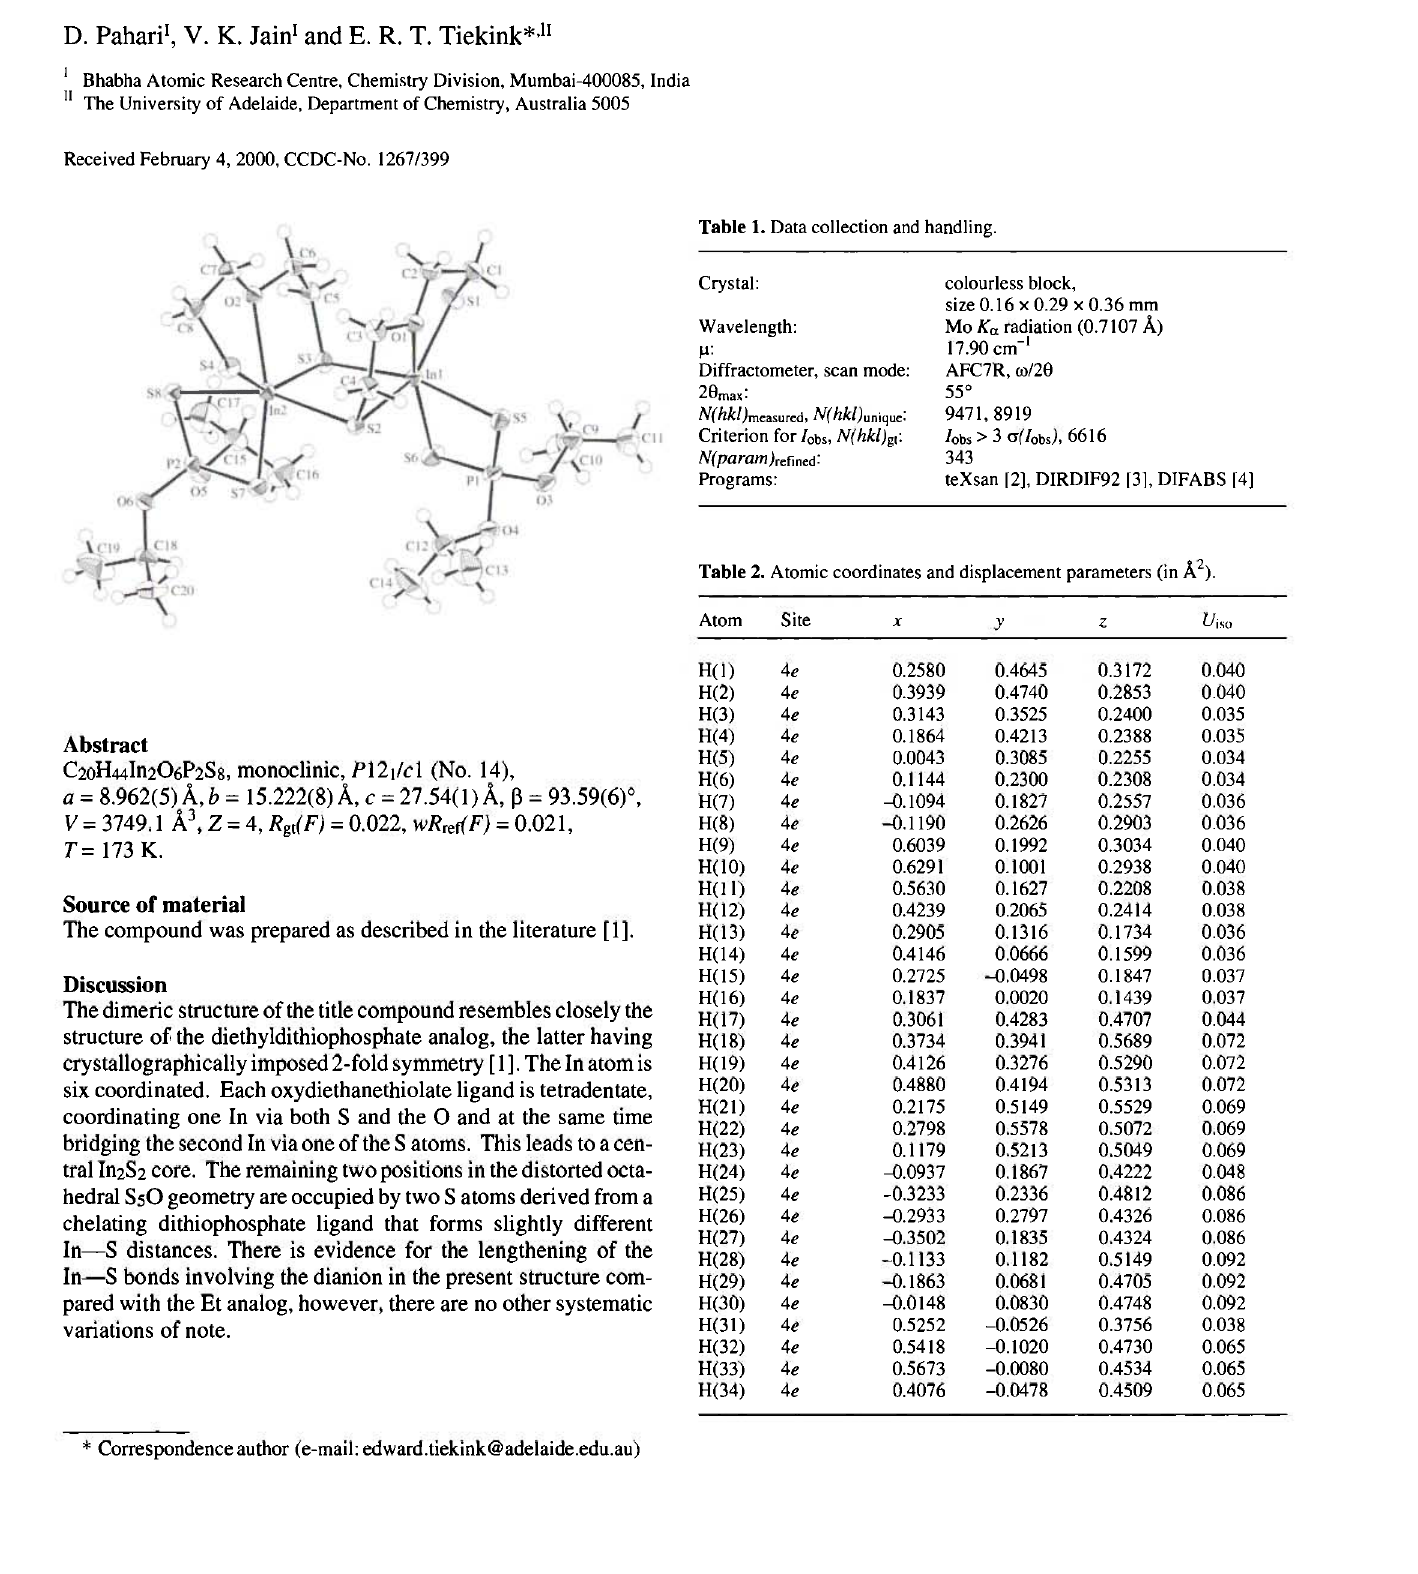
Table 2. Atomic coordinates and displacement parameters (in Ä 2